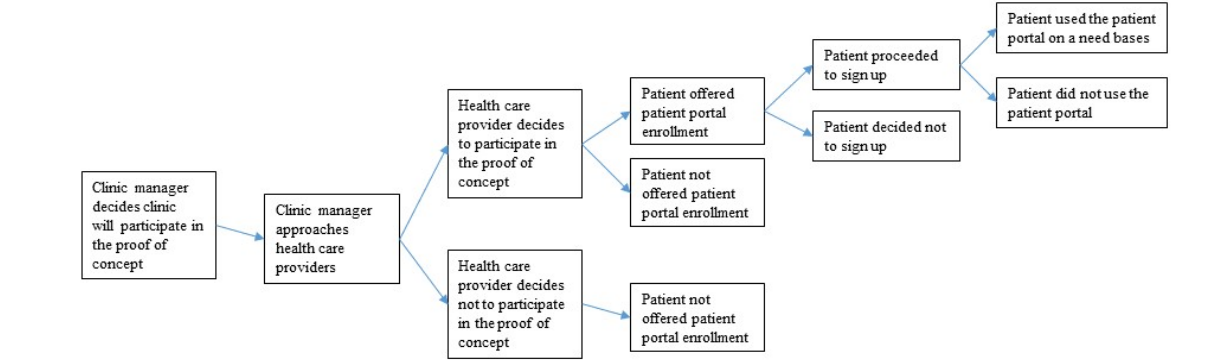
Figure 2. Clinic managers as gatekeepers to uptake of